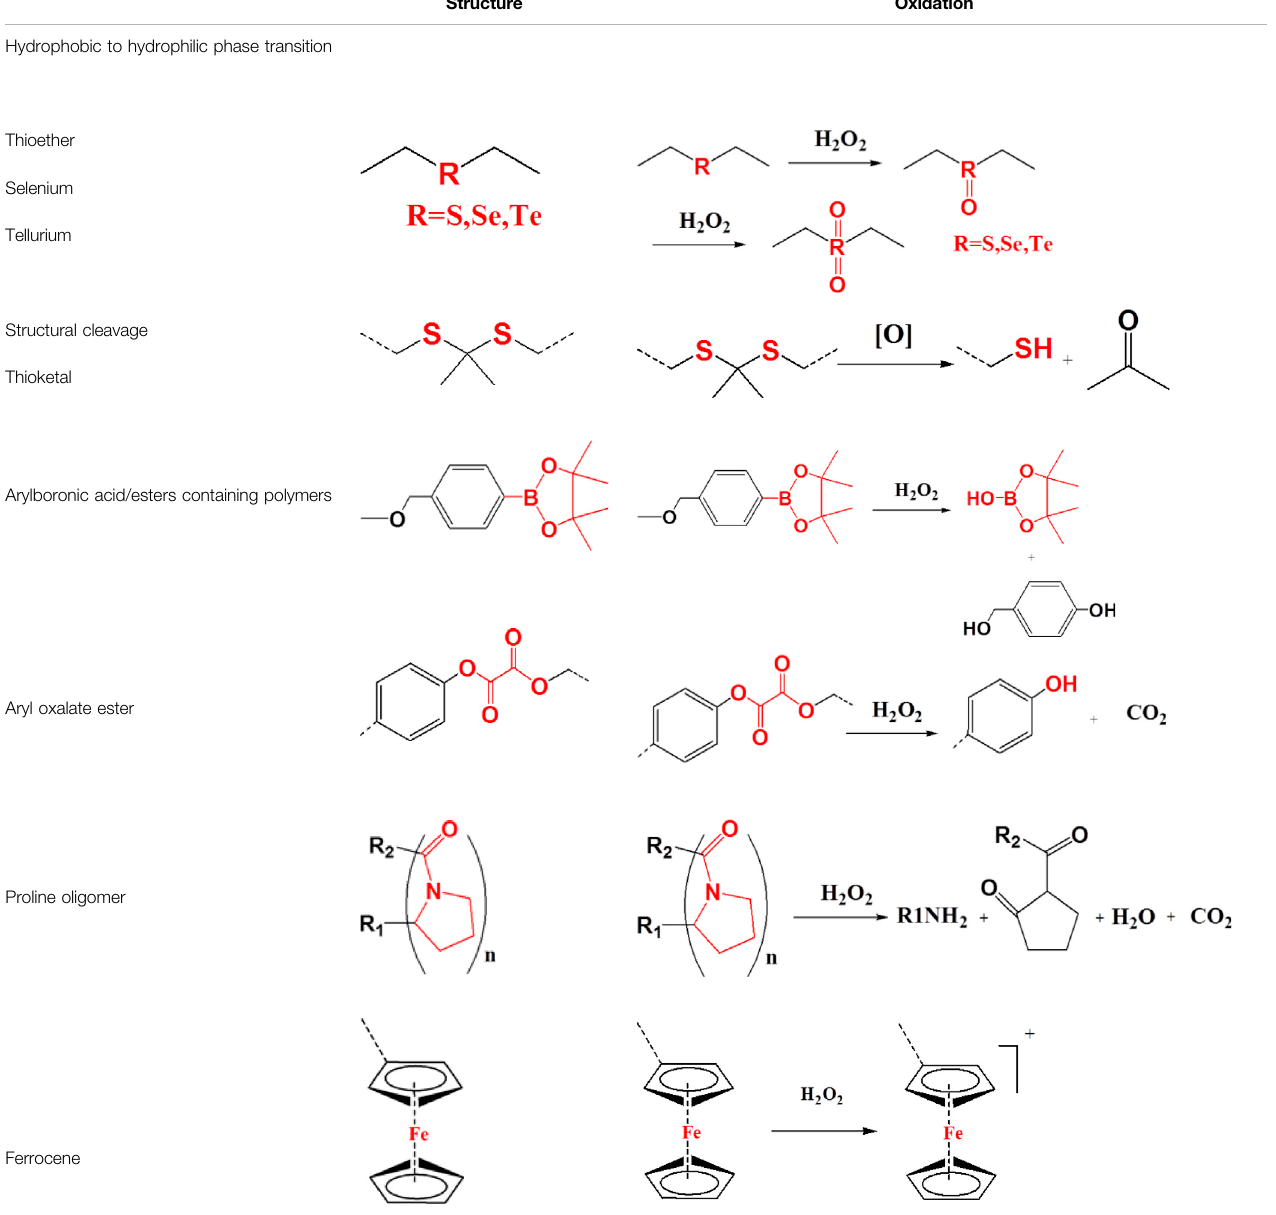
TABLE 1 | ROS-responsive polymer structures and mechanisms of activity (Ye et al., 2019). Copyright 2019, the American Chemical Society.